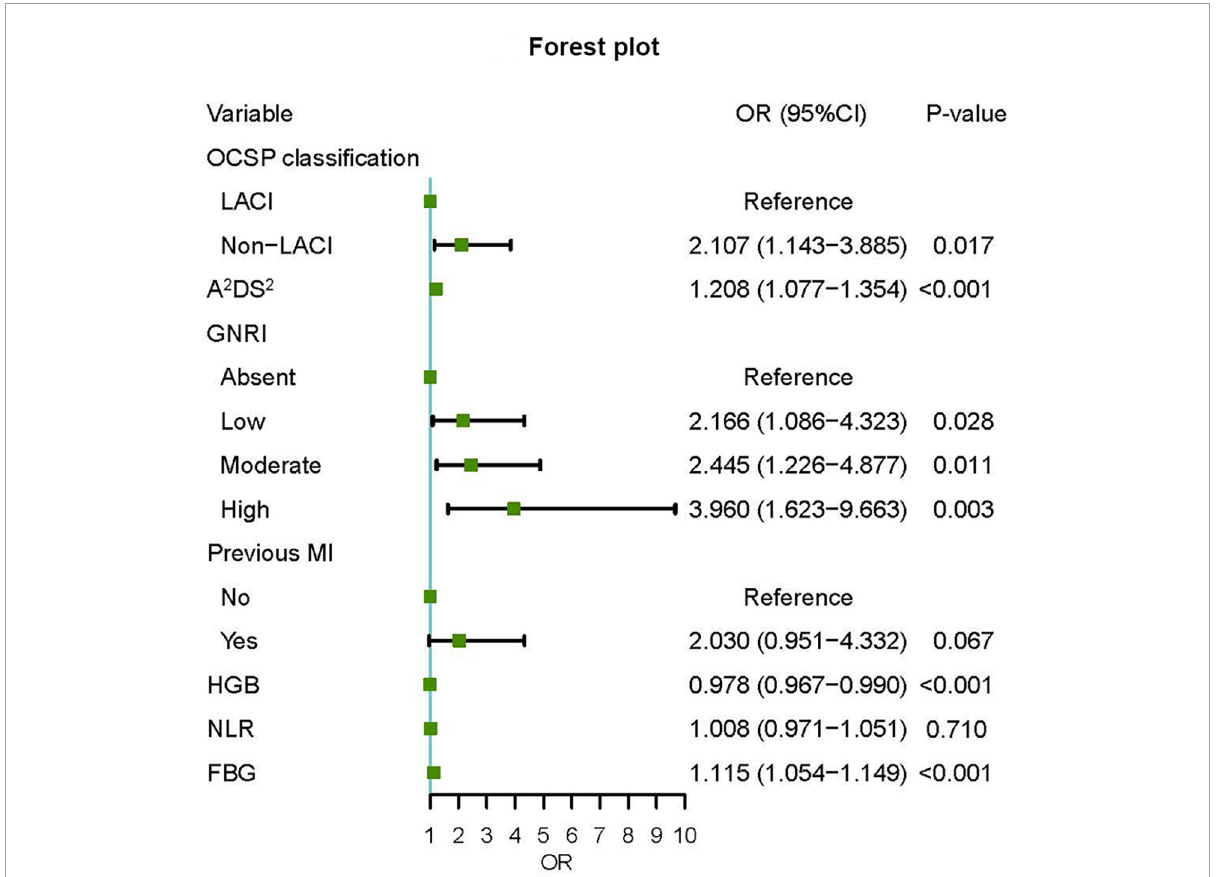
FIGURE2 Forest plot of odds ratios for SAP. An OR (odds ratios) > 1 meant an increased risk of SAP (stroke-associated pneumonia); an OR < 1 meant the opposite. OCSP, Oxfordshire Community Stroke Project; LACI, lacunar circulation infarction; GNRI, Geriatric Nutritional Risk Index; MI, myocardial infarction; NLR, neutrophil-to-lymphocyte ratio; FBG, fast blood